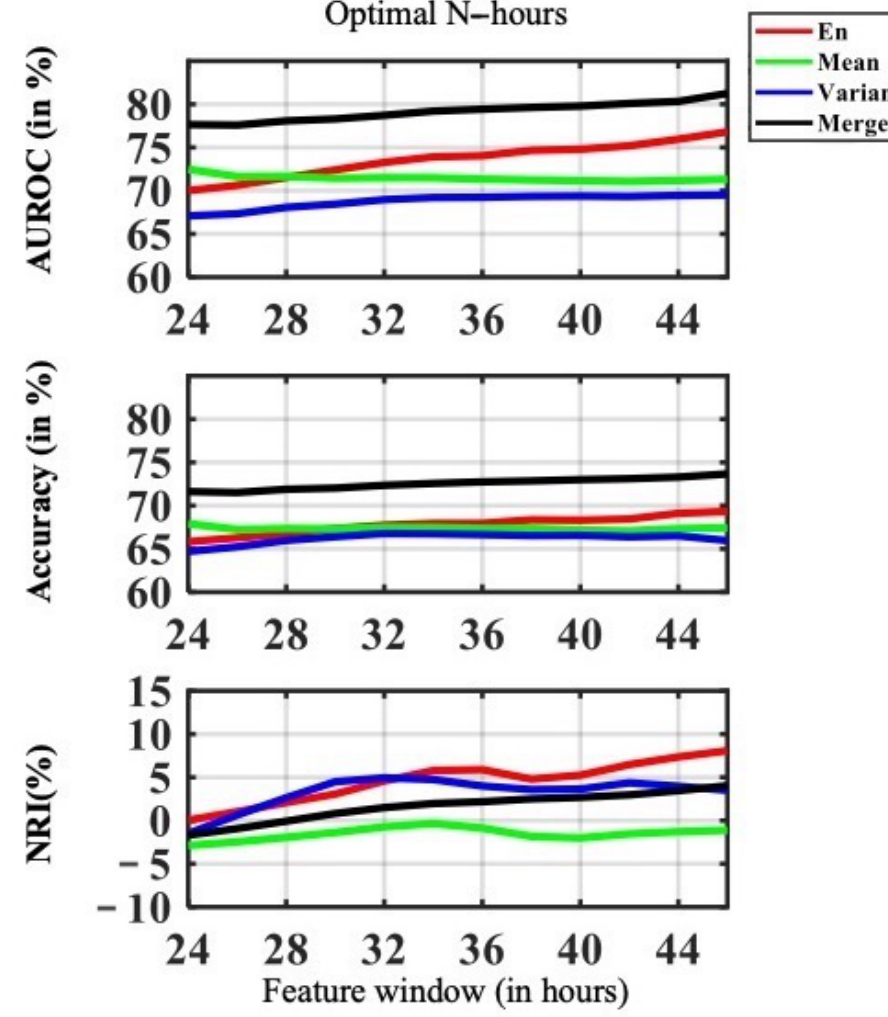
Figure 7. Visualization plot for feature window variation performance, with the feature window size varying from 24 h to 48 h before onset, with a time gap of 24